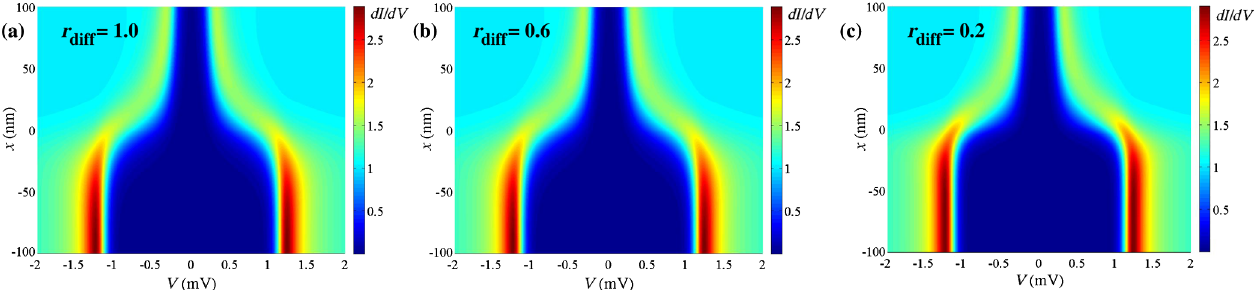
FIG. 14. Normalized tunneling spectra as a function of the bias voltage and the position measured with respect to the island edge. These results were obtained in self-consistent calculations that take into account the inverse proximity effect in the island. The three panels correspond to different values of the diffusion constant ratio r